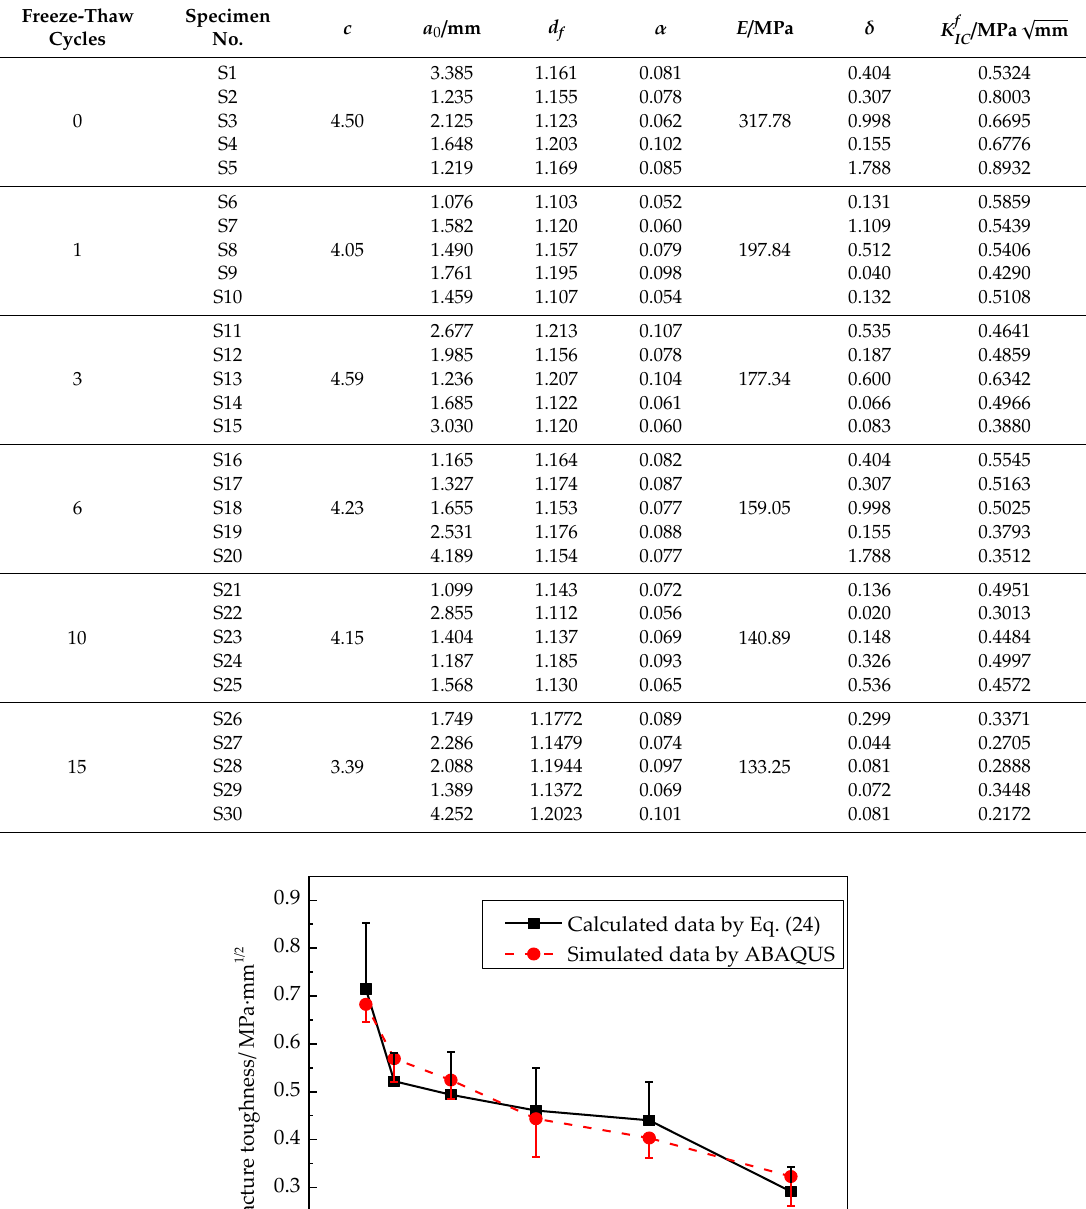
Table 3. Fracture toughness and fractal dimension.